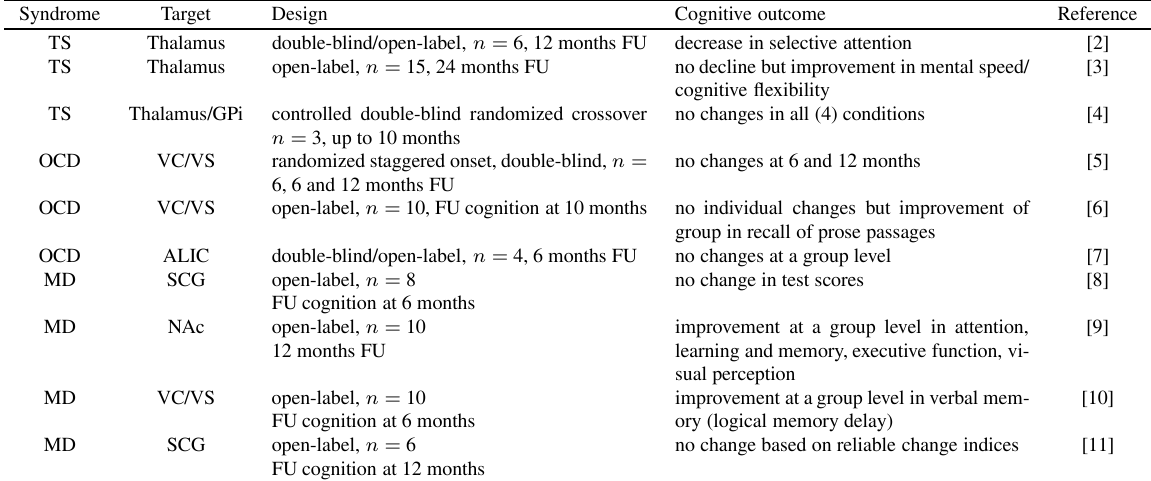
Table 1 DBS and cognitive outcome in patients with refractory psychiatric